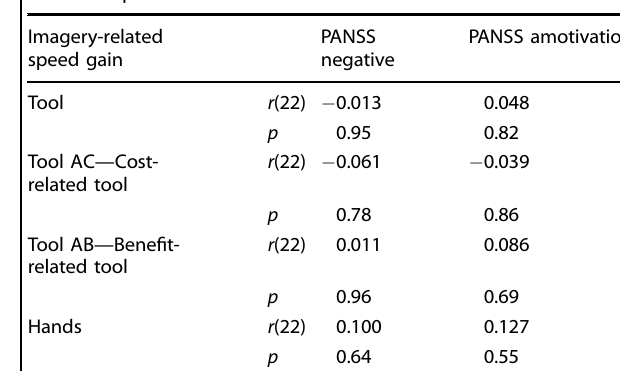
Table 2. Spearman